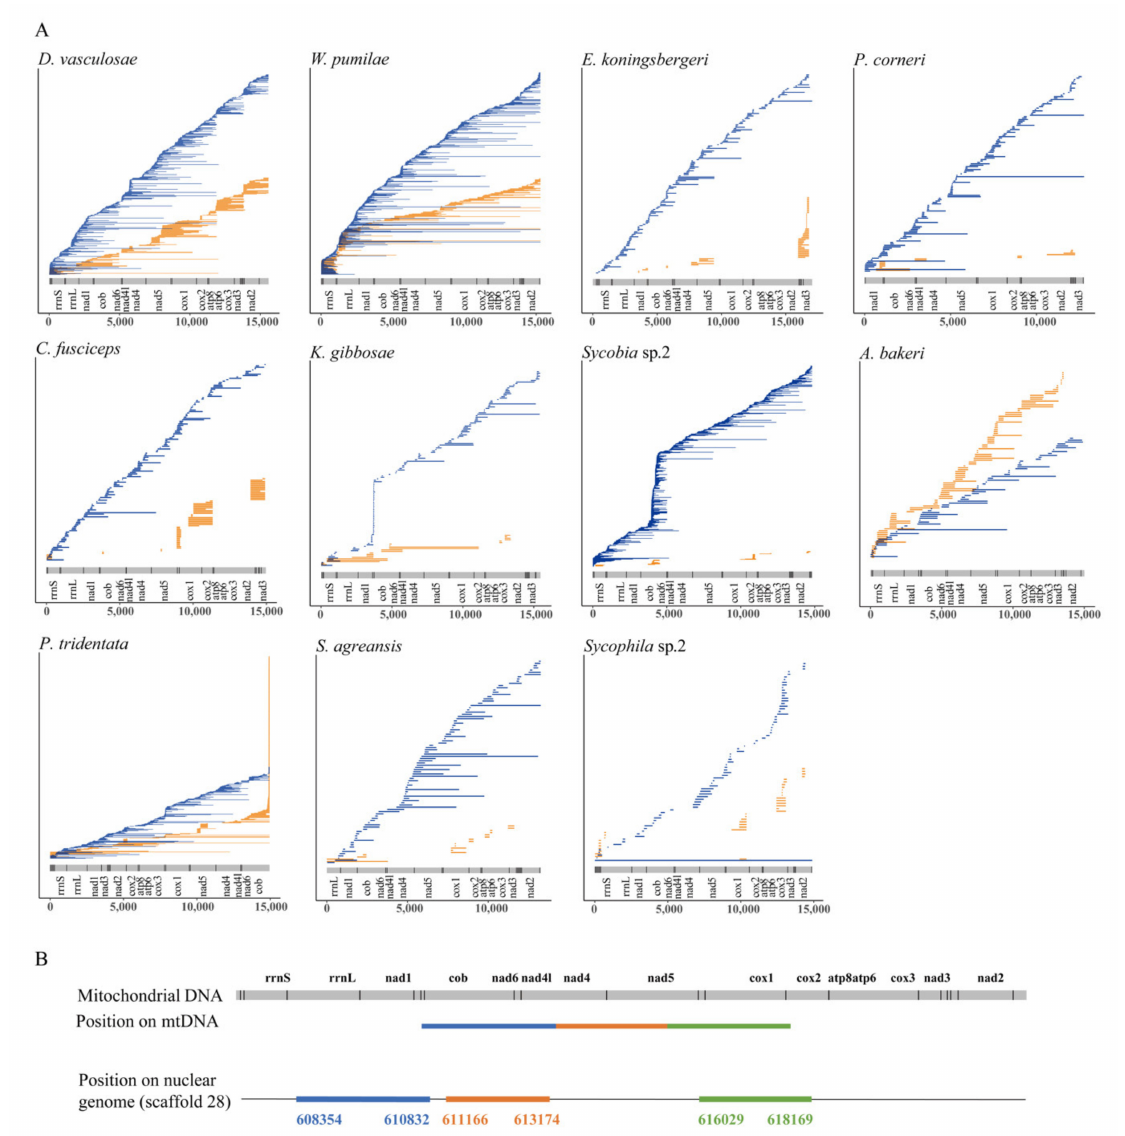
Figure 2. Mapping of NUMTs and their mitochondrial genome regions ( A ) and a detailed display of one example of fragmentation event in the species of A. bakeri ( B ). ( A ) For each species, the NUMTs were mapped onto their original positions on the mitochondrial genome (the length and mitochondrial genes are shown in the bottom). The orange lines represent the “duplicate type” NUMTs and the blue lines represent “insertion type” NUMTs. ( B ) The picture shows a 9815 bp long sequence containing three NUMTs (in di ff erent colors) on sca ff old 28 in the genome of A. bakeri (in the bottom) and the origin of the three NUMTs on its mitochondrial genome (on the top). The numbers show the start and end positions of di ff erent NUMTs on the sca ff old. On the mitochondrial genome, transfer RNA genes are indicated with vertical lines. Acronyms: nad1-6, NADH dehydrogenase subunits 1 to 6; cox1–cox3, cytochrome c oxidase subunits I to III; atp6 and atp8, ATP synthase 6 and 8; cob, cytochrome b; rrnL and rrnS, 16S and 12S